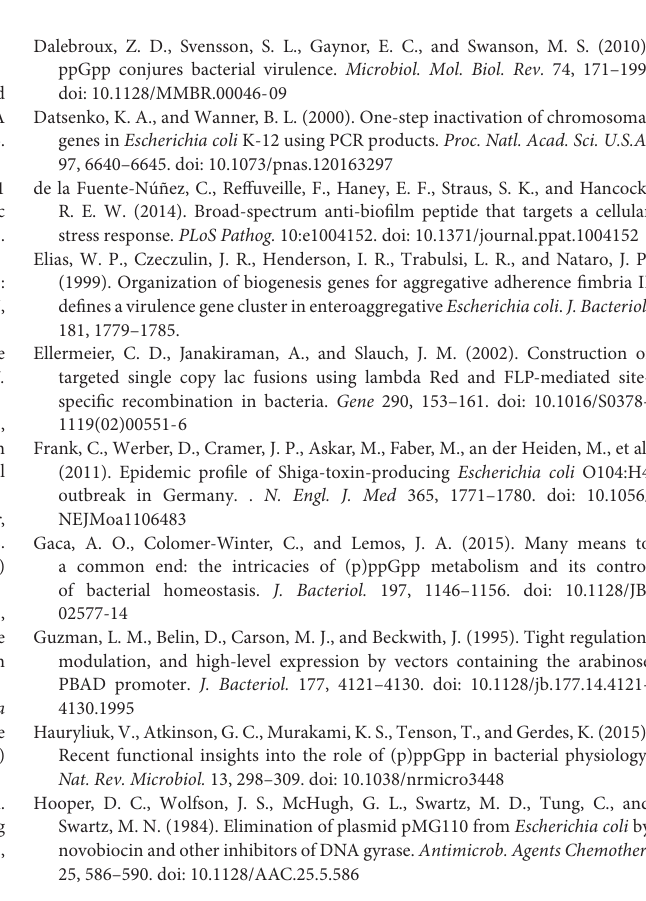
FIGURE S1 | Full Western blot membrane showing the AggR-Flag and AafA-Flag expression corresponding to Figure 4 , lanes 1 and 3 WT, lanes 2 and 4 relA mutant. FIGURE S2 | Full Western blot membrane showing the AggR-Flag expression corresponding to Figure 4 , lane 1 WT and lane 2 relA spoT mutant. FIGURE S3 | Full Western blot membrane showing the AafA-Flag expression corresponding to Figure 4 , lane 1 WT and lane 2 relA spoT mutant. FIGURE S4 | Complementation of the double relA spoT mutantion by providing SpoT in trans by using the pBR322-SpoT plasmid. (A) M9 minimal medium agar plate showing that the ppGpp 0 strain ( (cid:49) relA (cid:49) spoT ) is able to grow in M9 medium in the presence of pB322-SpoT plasmid. (B) Western blot showing that AafA-Flag protein expression is increased in the (cid:49) relA (cid:49) spoT mutant when SpoT is provided in trans . (1) 042 WT (wild-type strain), (2) 042AafAFlag (wild-type strain expressing AafA-Flag), (3) 042AafAFlagrelAspoT [(p)ppGpp 0 derivative of 042 strain expressing AafA-Flag], (4) 042AafAFlagrelAspoT pBR322 (AafA-Flag ppGpp 0 strain with control vector), and (5) 042AafAFlagrelAspoT pBR322-SpoT (AafA-Flag ppGpp 0 strain expressing SpoT in trans ). TABLE S1 | Oligonucleotides used in this